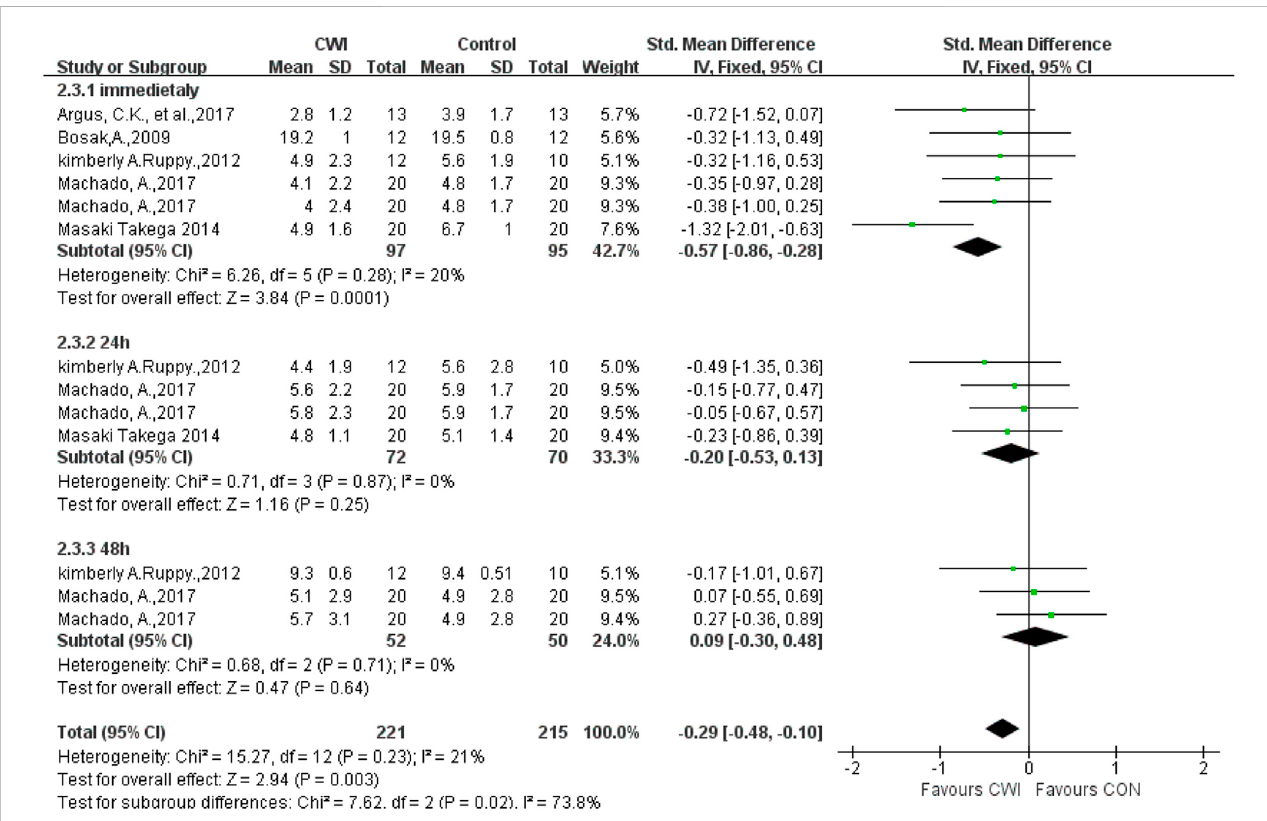
FIGURE 6 Forest plot of the comparison of CWI versus CON for measurement of RPE. CWI = Cold water immersion, CON = Control, RPE = rate of perceived exertion.